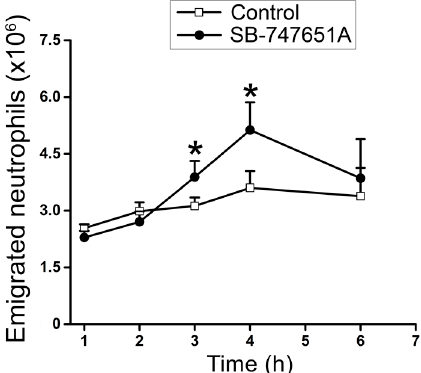
Figure 5. Effect of SB-747651A on CXCL2-induced neutrophil emigration in peritoneum. Time course of the number of emigrated neutrophils (×10 6 cells) counted in the peritoneal lavage fluid in the absence (Control, open square) or in the presence of MSK1 inhibitor SB-747651A (3 mg/kg, i.p. 30 min prior to CXCL2 injection, solid circle) collected at 1, 2, 3, 4, and 6 h after an i.p. injection of CXCL2 (0.5 µg/mouse). Data are means ± SEM ( n = 3). * indicates significant difference ( p < 0.05) from the Control.